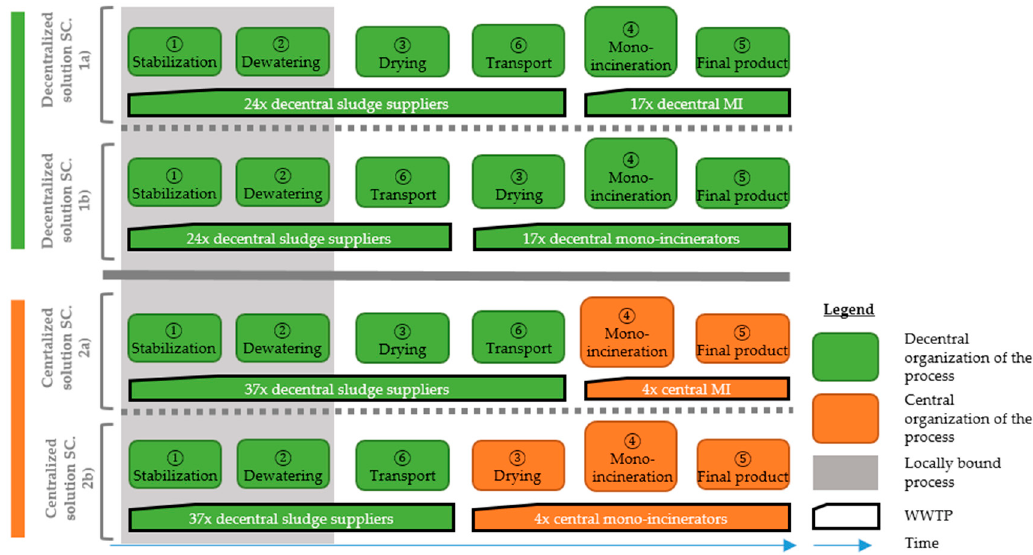
Figure 5. Results of the basic spatial perspectives for the mono-incineration process. Characteristics of scenario 1, 2( a ), and 2( b ).